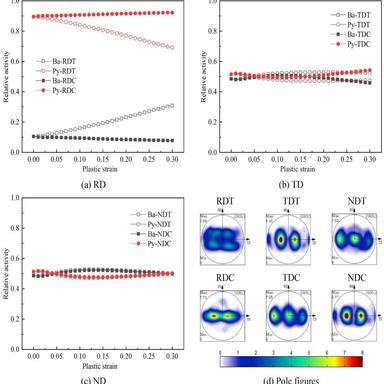
Relative activities of individual deformation modes under different loading conditions when only Ba and Py are activated in the thought experiment, and the predicted pole figures after 20% tension/compression along six directions. Ba mainly coordinates the deformation along the TD and ND.